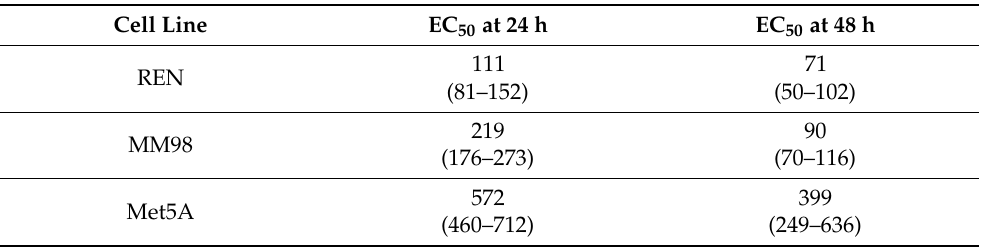
Table 2. BOLD-100 effect on cell viability evaluated in terms of EC 50 at 24 or 48 h. Each value comes from the results of three independent experiments. In brackets, the 95% confidence interval. Concentrations are indicated as µ M.